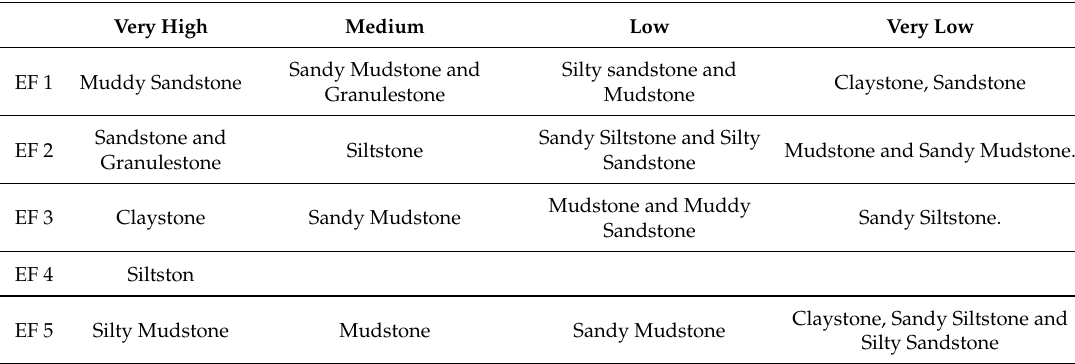
Table 6. The lithologic descriptions of the